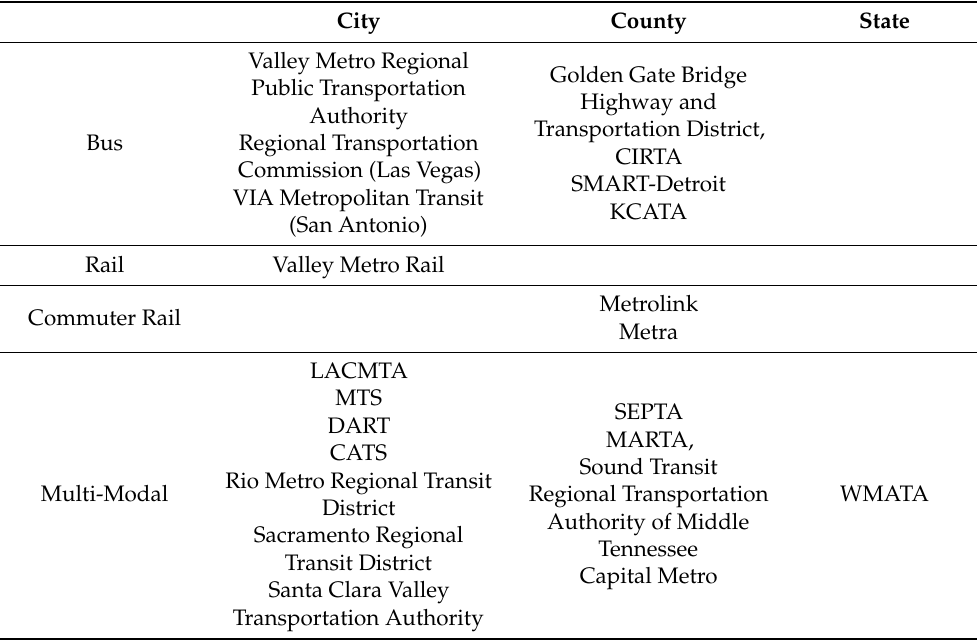
Table 3. Intergovernmental Governance by Level of Control and